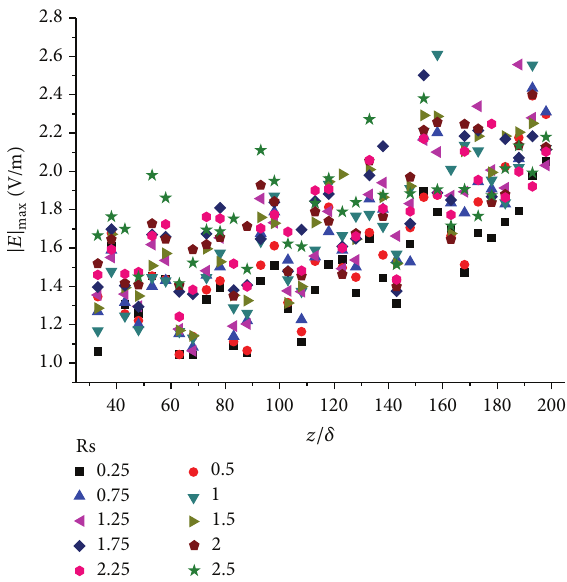
Figure 3: |𝐸| max distributions at different 𝑧 planes with various Rs at 𝑟 = 60𝛿 .